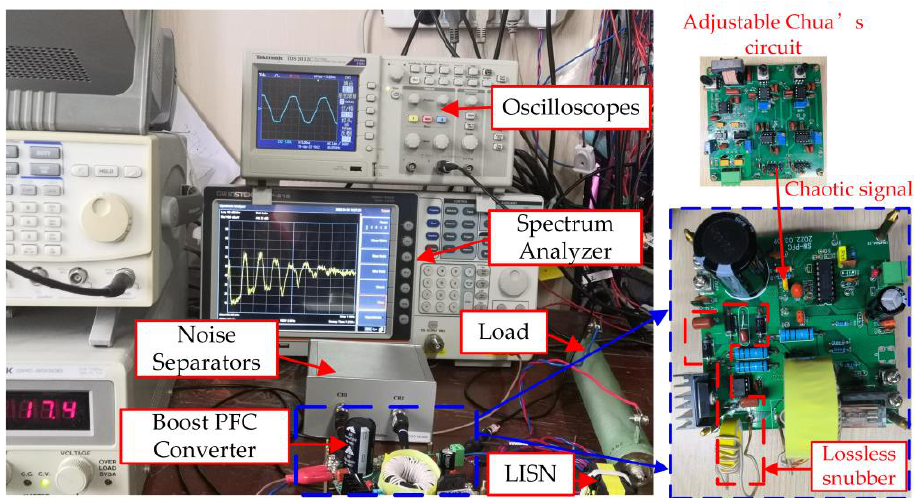
Figure 11. Experiment platform.